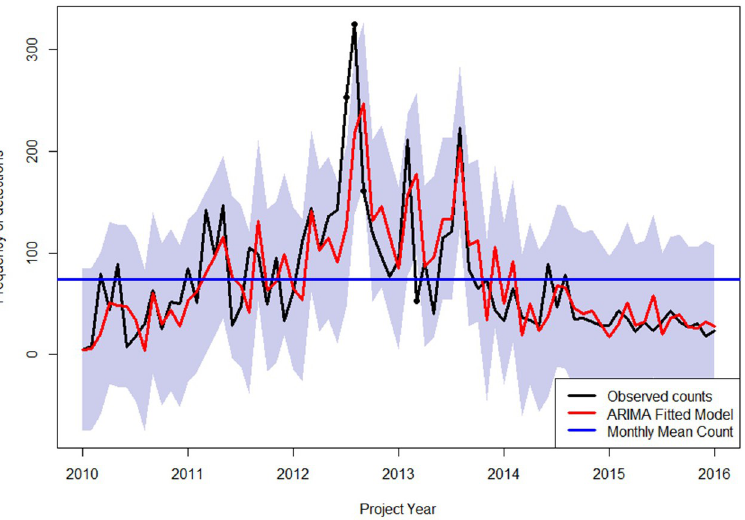
Fig 4. Time series model for total border detection counts between January 2010 and September 2015 for Barrow